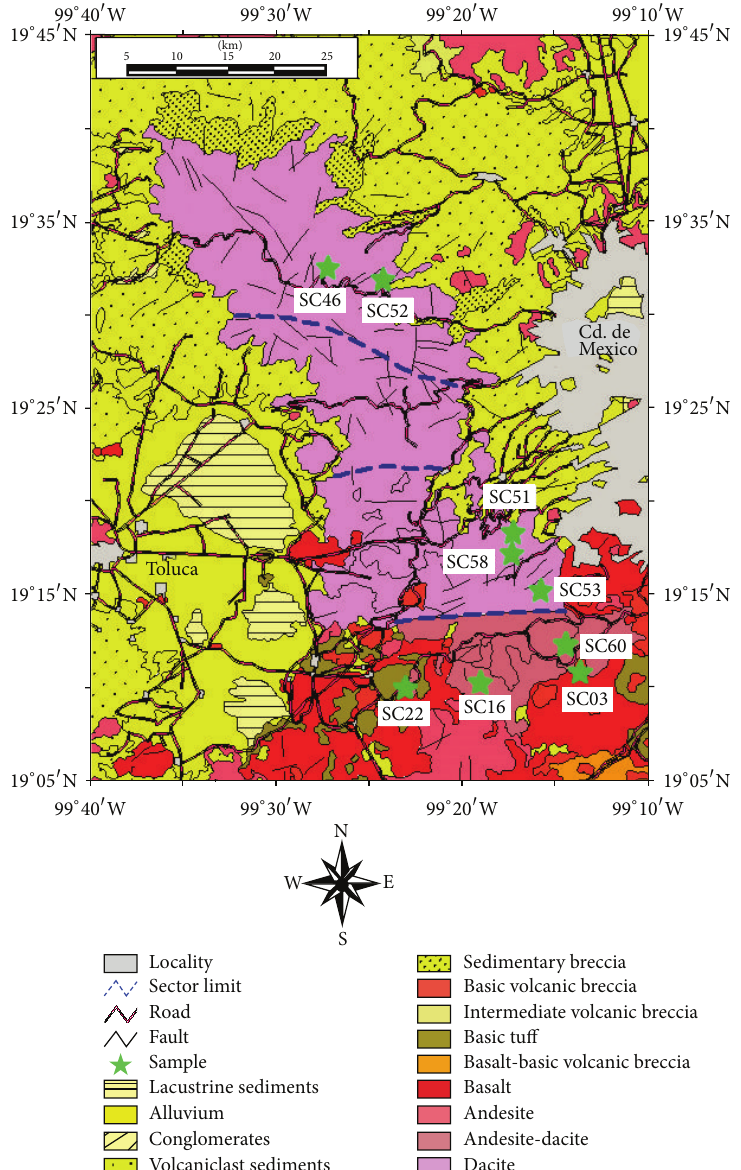
Figure 2: Geologic sketch of the Sierra de las Cruces volcanic range, showing lithology, faults, roads, and distribution of the samples (green stars) collected along the volcanic range in this work (modified from [23]). Study area division in four sectors from N to S based on K-Ar radiometric data [26]: (a) SCN-northern sector (2.9–3.7 Ma), (b) SCC-central sector (1.9–2.9 Ma), (c) SCS-southern sector (0.7–1.9 Ma), and (d) SCT-transition sector that include the Ajusco volcano ( <